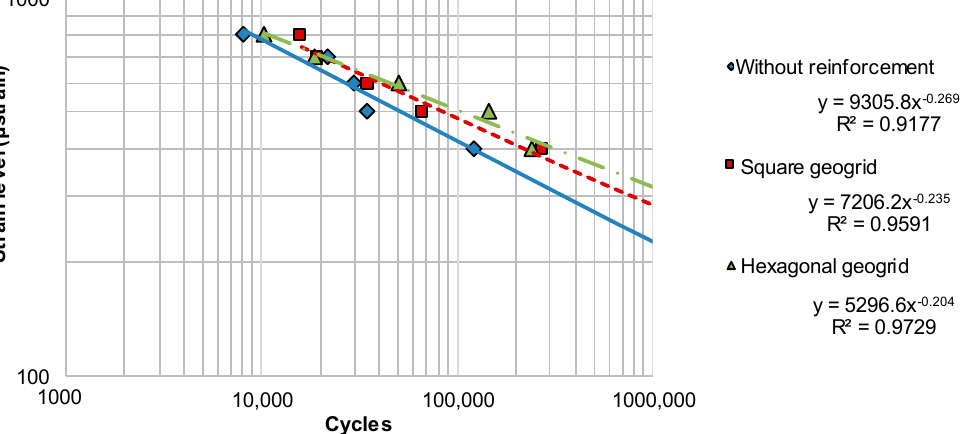
Figure 12. Fatigue model chart for double-layered asphalt beams.